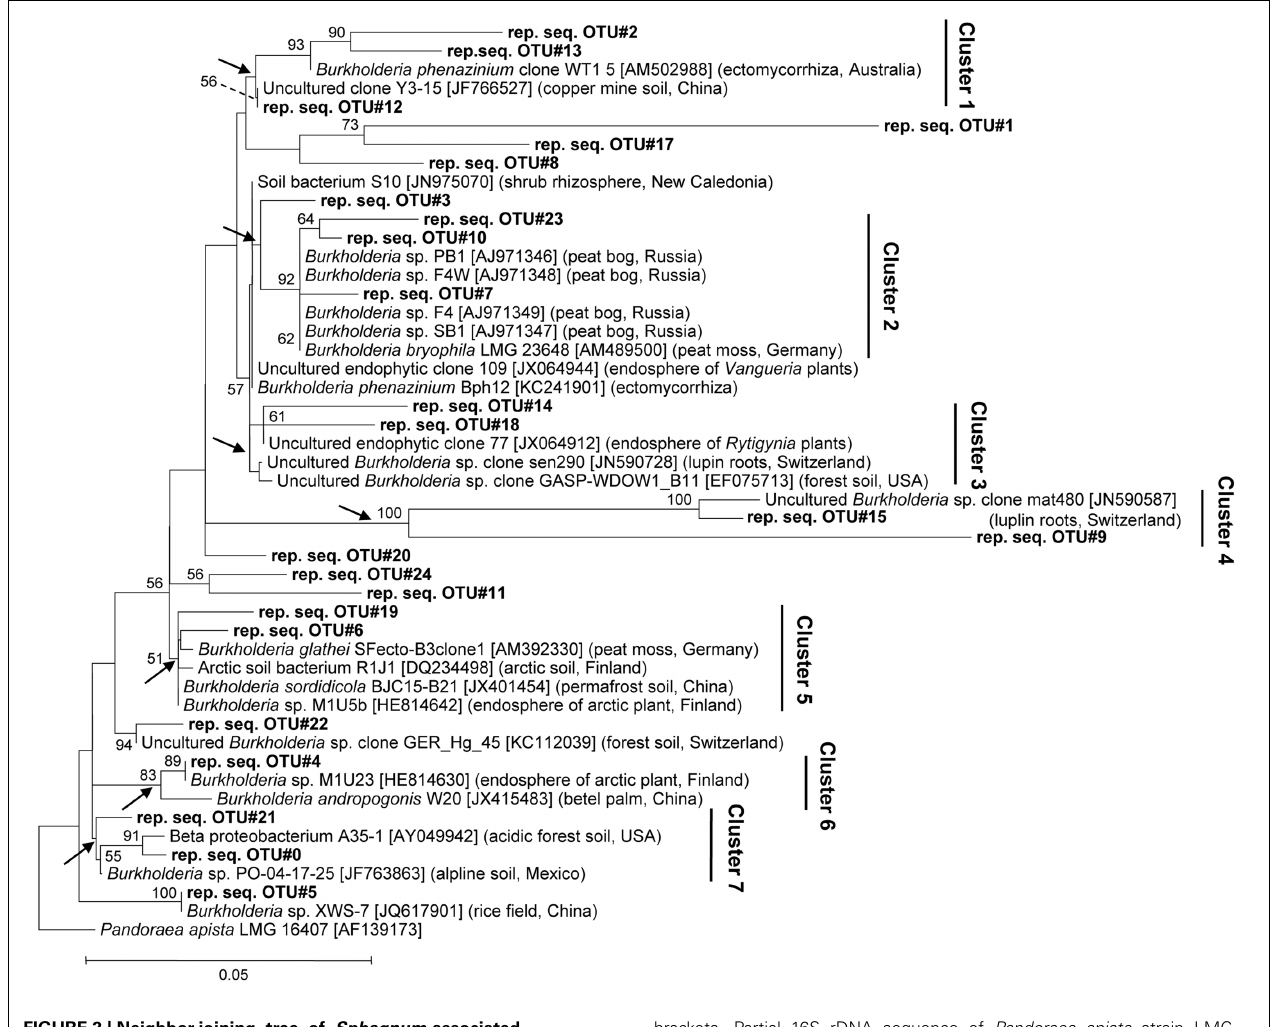
brackets. Partial 16S rDNA sequence of Pandoraea apista strain LMG 16407 (AF139173) was used as an out-group. Numbers at nodes indicate bootstrap values out of 100 data re-samplings exceeding 50%. Arrows show monophyletic branches for cluster designation. Distance bar: 0.05 substitutions per